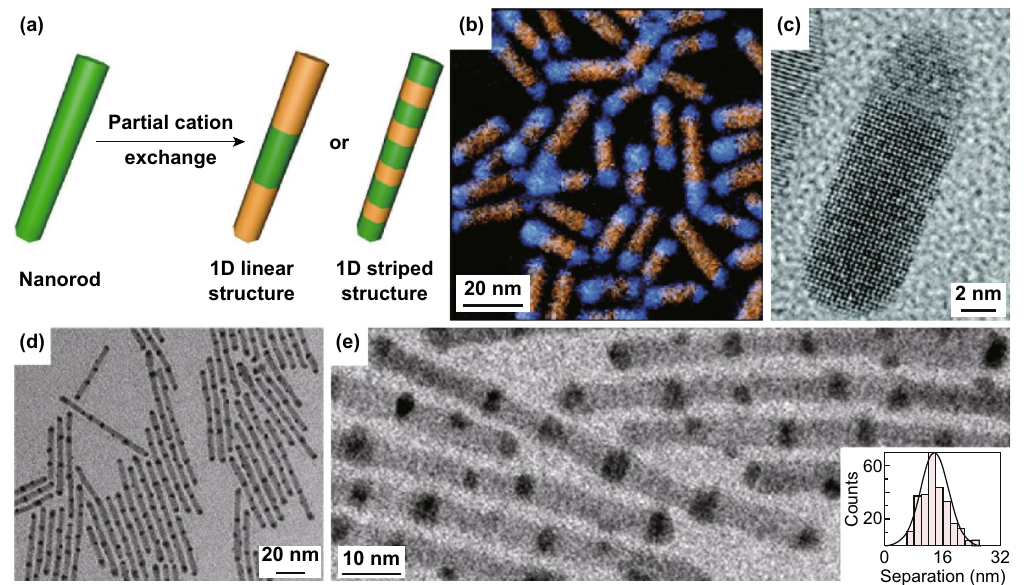
Fig. 4 a Schematic illustration of the synthesis of 1D linear structure and 1D striped structure by partial cation exchange. b Color‑composite energy‑filtered TEM image of CdS‑Cu 2 S nanorods. The orange regions correspond to the Cd energy‑filtered mapping, and the blue regions cor‑ respond to the Cu mapping. c HRTEM image of a CdS‑Cu 2 S nanorod. Reproduced with permission from Ref. [98]. Copyright 2009, American Chemical Society. d, e TEM images of transformed CdS‑Ag 2 S superlattices. Inset in e : Histogram of Ag 2 S segment spacing. Reproduced with permission from Ref. [100]. Copyright 2007, Science Publishing